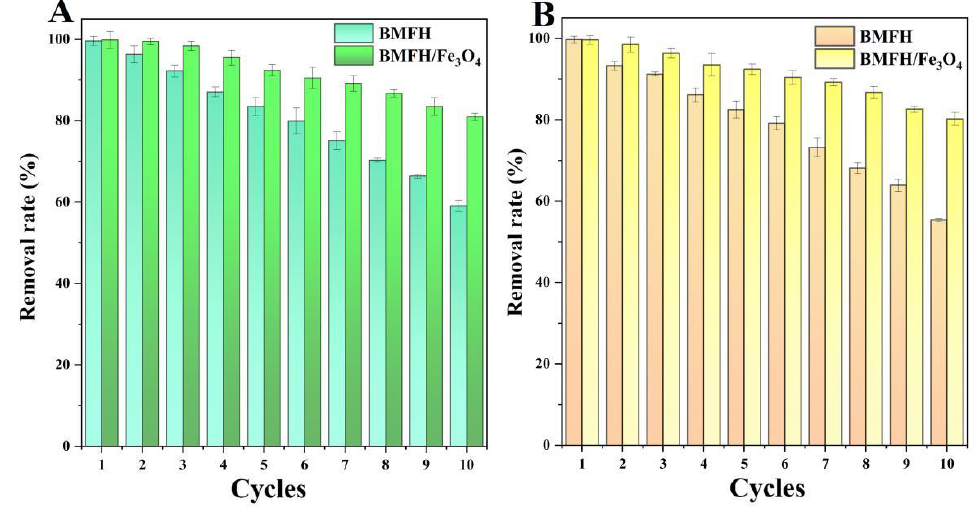
Figure 12. Cycling stability of the BMFH and BMFH/Fe 3 O 4 to remove (A) MG and (B) TH.